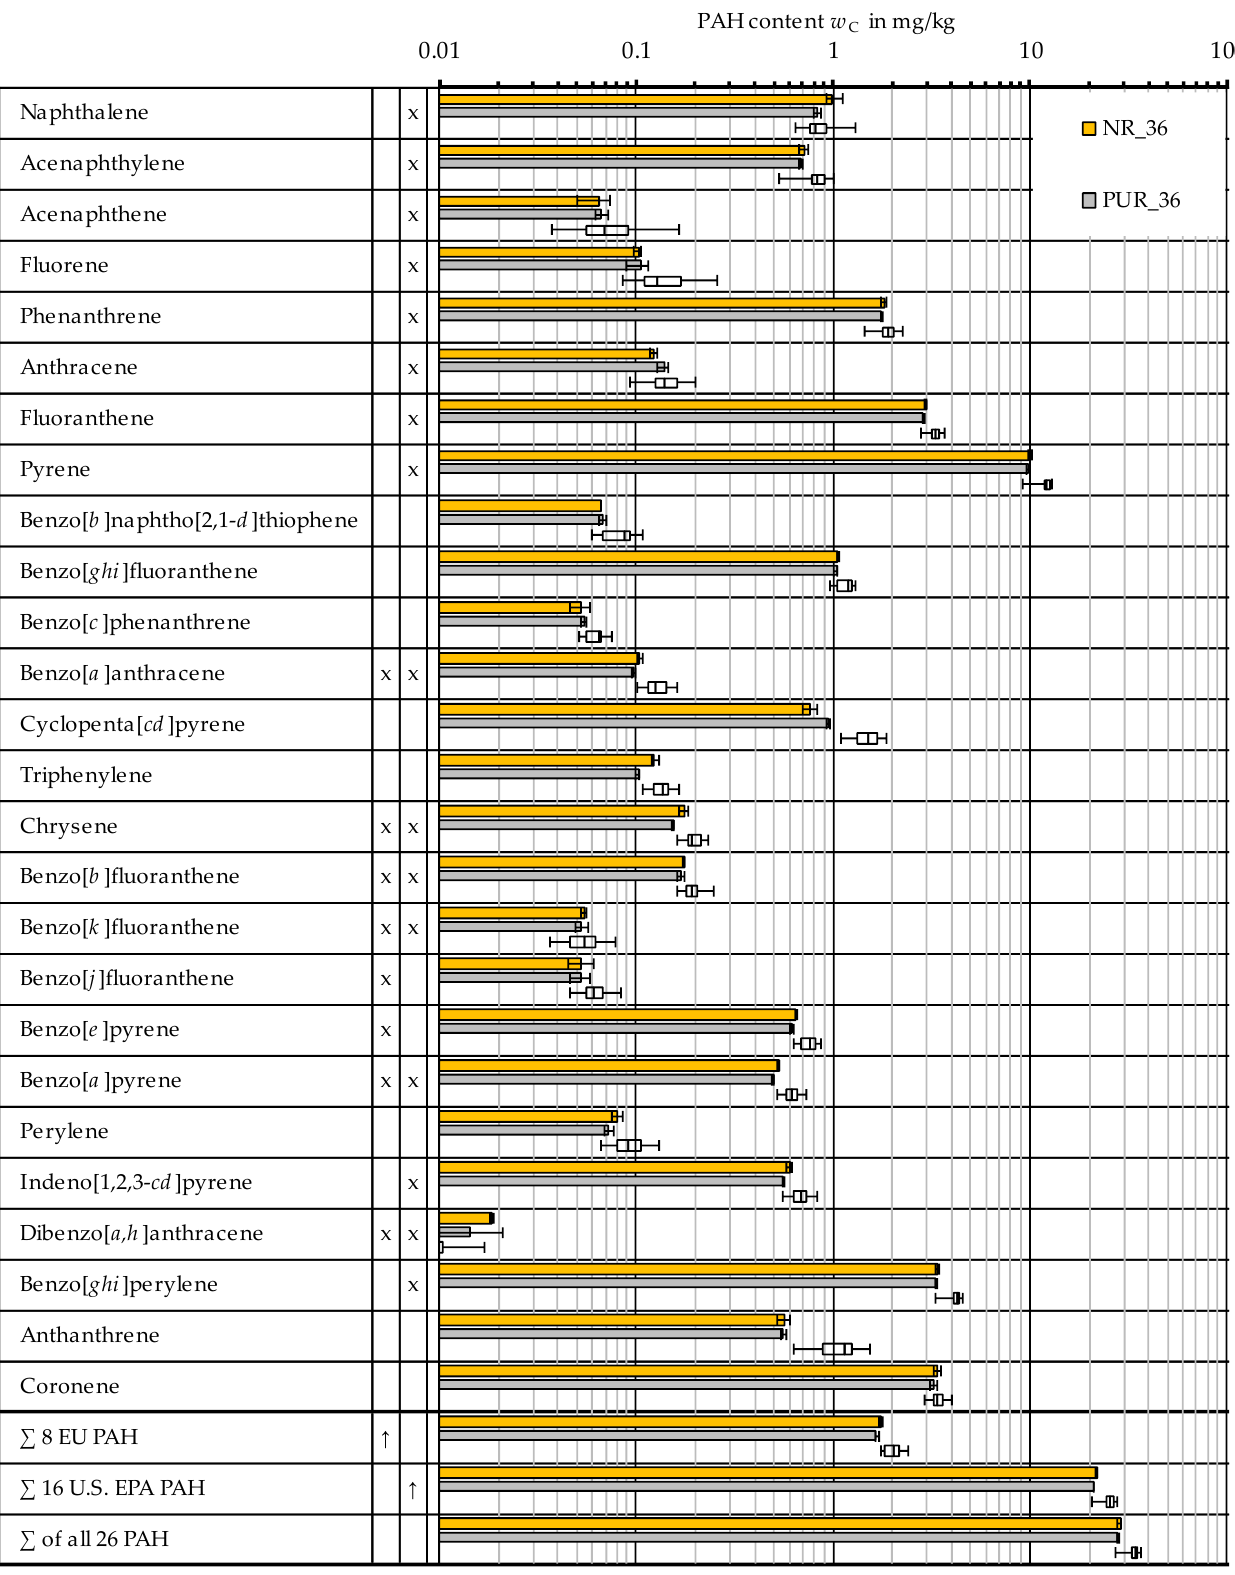
Figure 1. Arithmetic mean as well as minimum and maximum of the triple measurement of the PAH content for PUR_36 and NR_36 (bar graph). Expected value range of the PAH content based on the ELT content of 36% (boxplot). In the second and third columns, the compounds belonging to the sum values are marked with an “ x ” , the arrow indicates the relevant column.